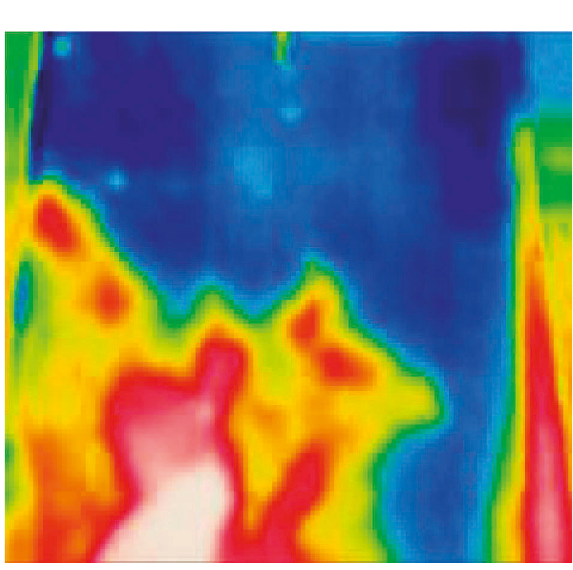
Figure 2: Thermal image of the faulty solar panel with the contrast level adjusted